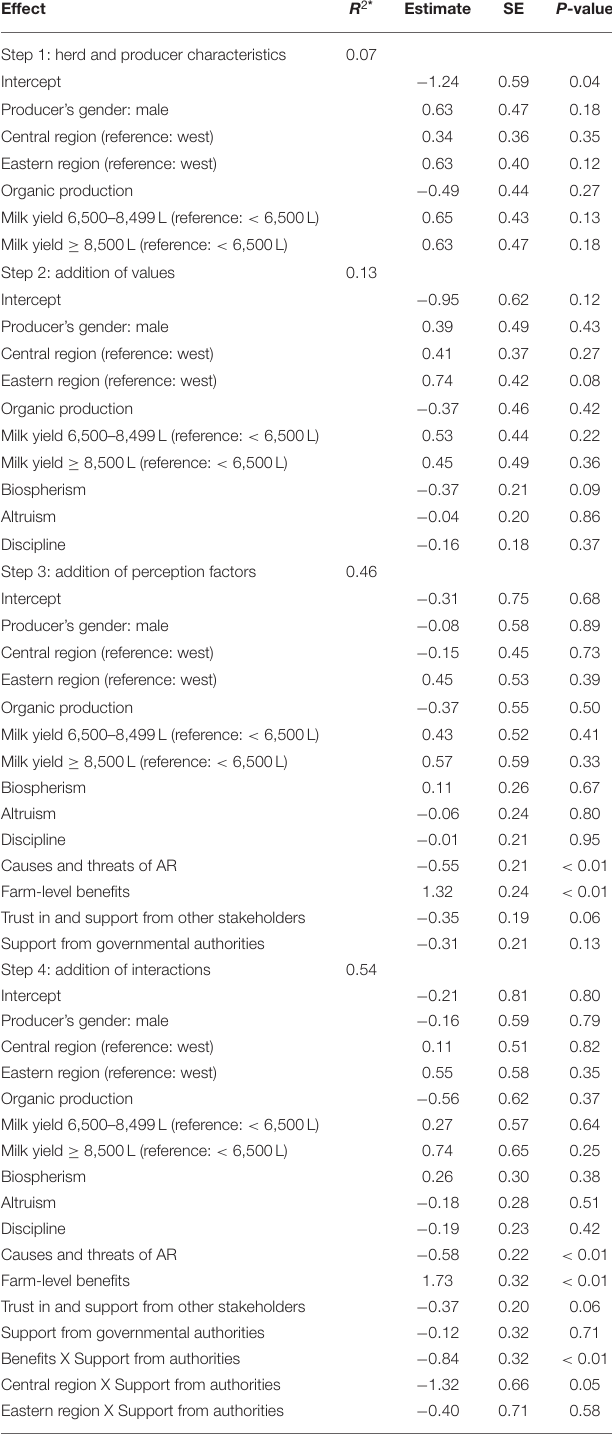
TABLE 7 | Logistic hierarchical regression model on the probability of feeding waste milk containing antibiotic residues (WMA) to calves (dependent variable), as a function of herd and producer characteristics and factors derived from factor analyses of personal values and perception items related to the feeding of WMA to calves and antibiotic resistance (AR), based on responses from 199 producers (31 missing herd or producer